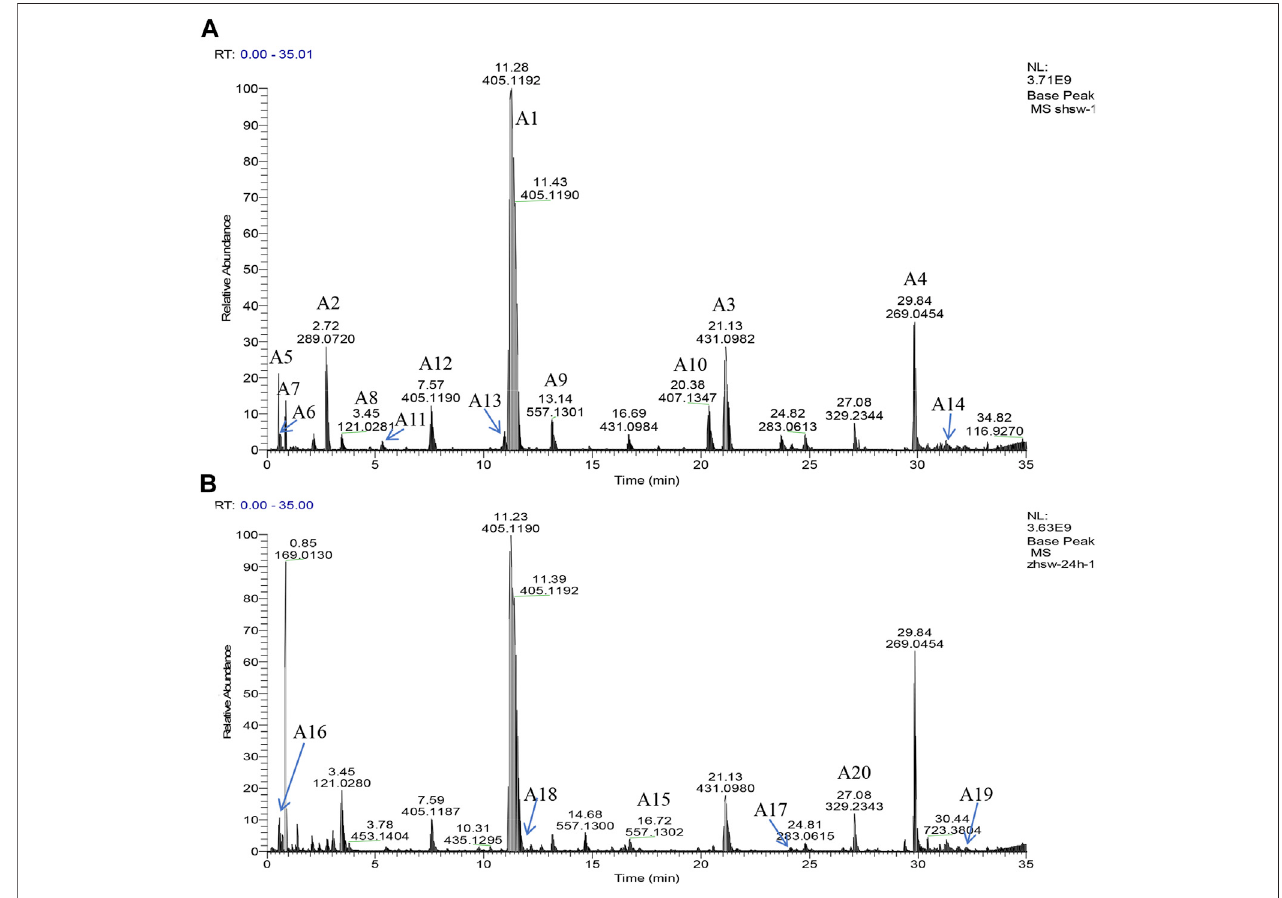
FIGURE2| Representativebasepeakintensitychromatogramsofsamplesof Reynoutriamulti fl ora withdifferentprocessingtimesderivedfromUHPLC-QExactive plus orbitrap MS/MS. (A) Raw Reynoutria multi fl ora (RRM), (B) Processed Reynoutria multi fl ora (PRM 24 h). Refer to Table 1 for compound labels in the fi gure.